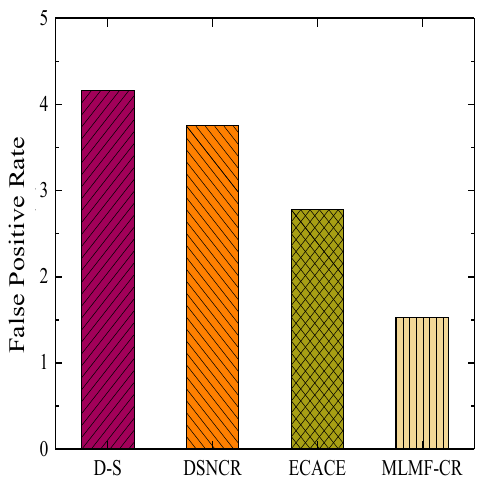
Figure 14. Misjudgment rate of each fusion